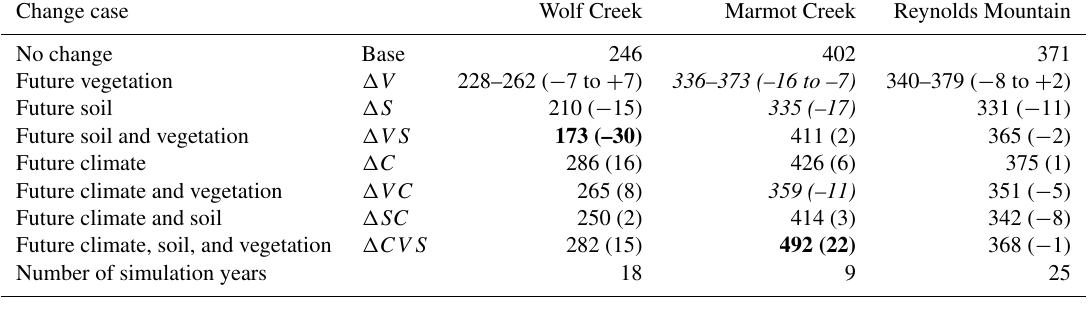
Table 5. Simulated runoff characteristics including annual volume under current and monthly perturbed climates and future vegetation in the three basins. Bold and italic values denote significant changes with p values of less than 0.05 and 0.1, respectively, based on a Mann–Whitney U test. Simulated distributions with n = 18 years for Wolf Creek, 9 years for Marmot Creek, and 25 years for Reynolds Mountain over the present (base case) period for each hydrological variable are compared with the simulated future distributions obtained from 11 regional climate models (11 × n values). The percentage change, relative to the current climate/vegetation, is given in parentheses.